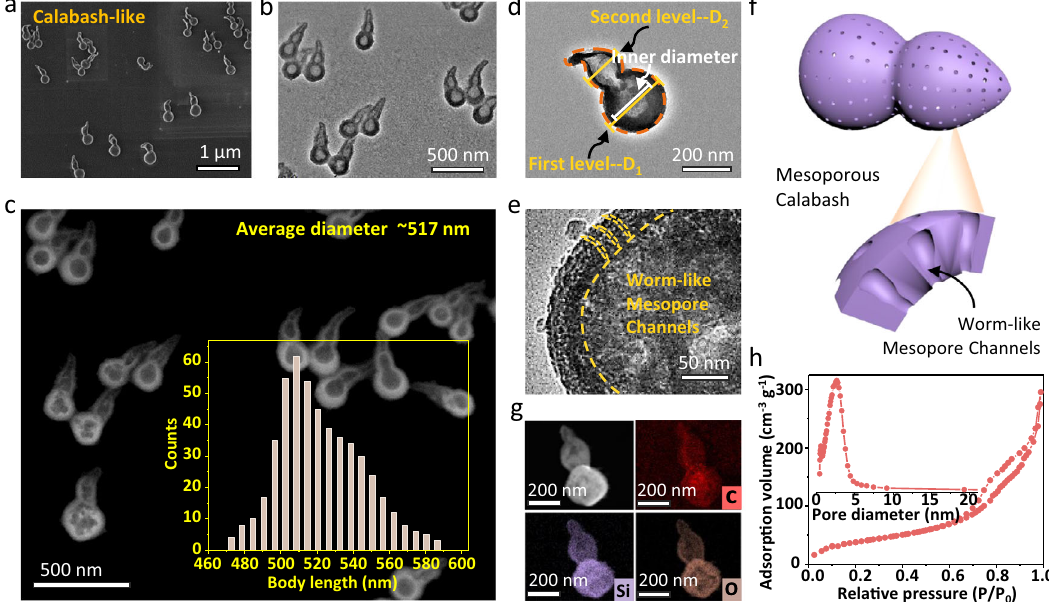
Fig. 1 | Calabash-like mesoporous silica nanoparticles. a SEM, b , d , e TEM, and c dark- fi eld TEM images of the dual-chambered mesoporous silica nanoparticles with different magni fi cations; Inset of c is the corresponding distribution histo- gramsoftheparticlebodylengths. f Thestructuralmodel,and g elementmappings